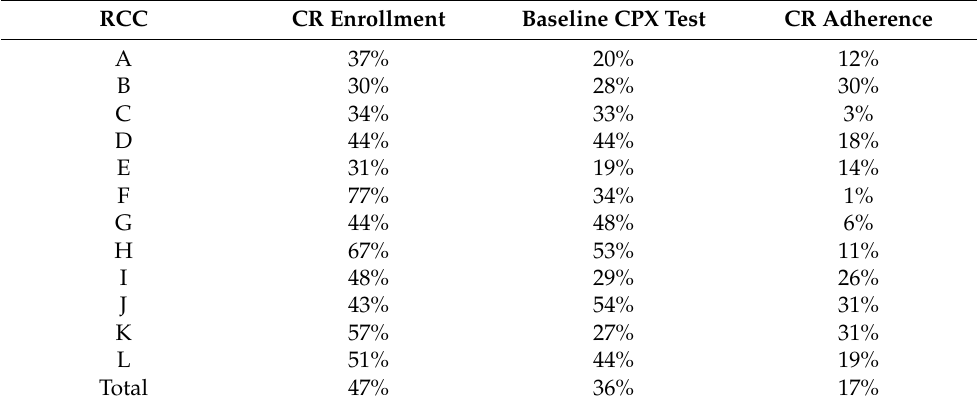
Table 8. Rate of Outpatient CR Enrollment, Performing Baseline CPX Test, and CR Adherence.